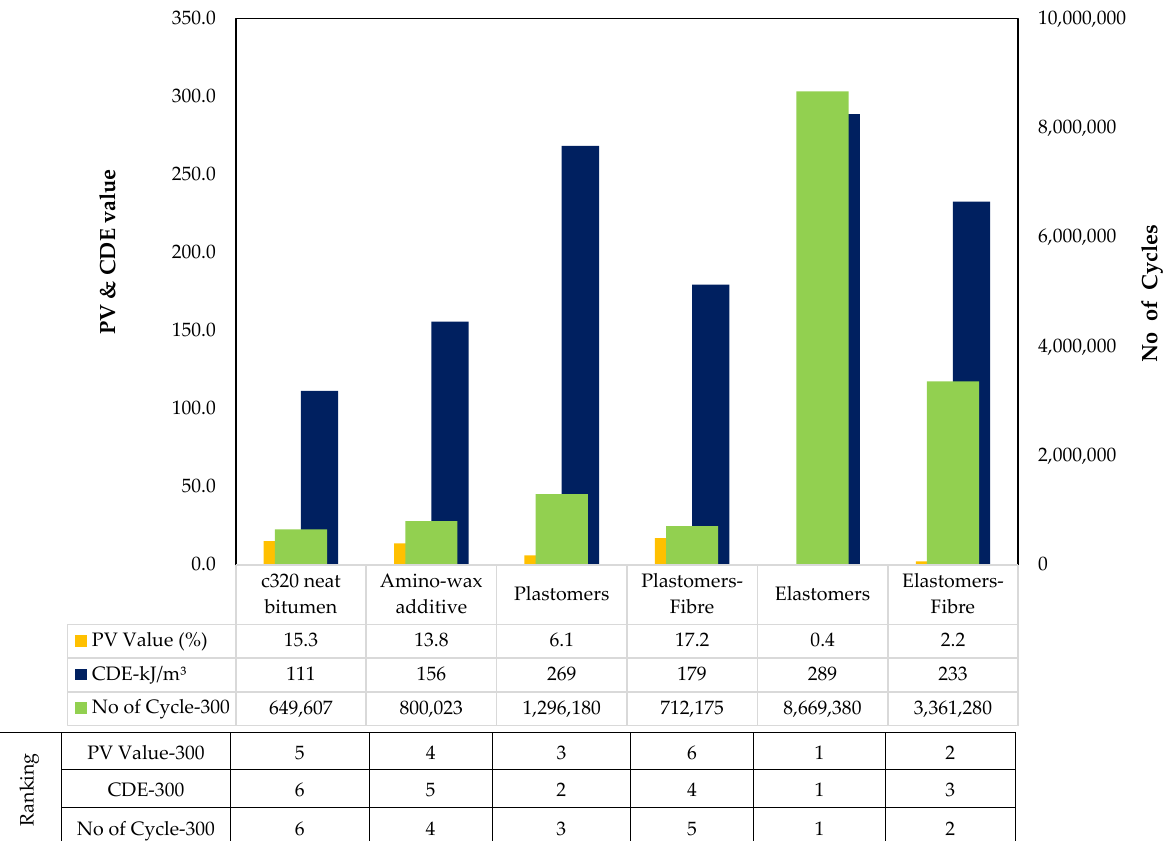
Figure 10. Ranking and properties of HMA mixes@300 μ strain for FBBT tests.